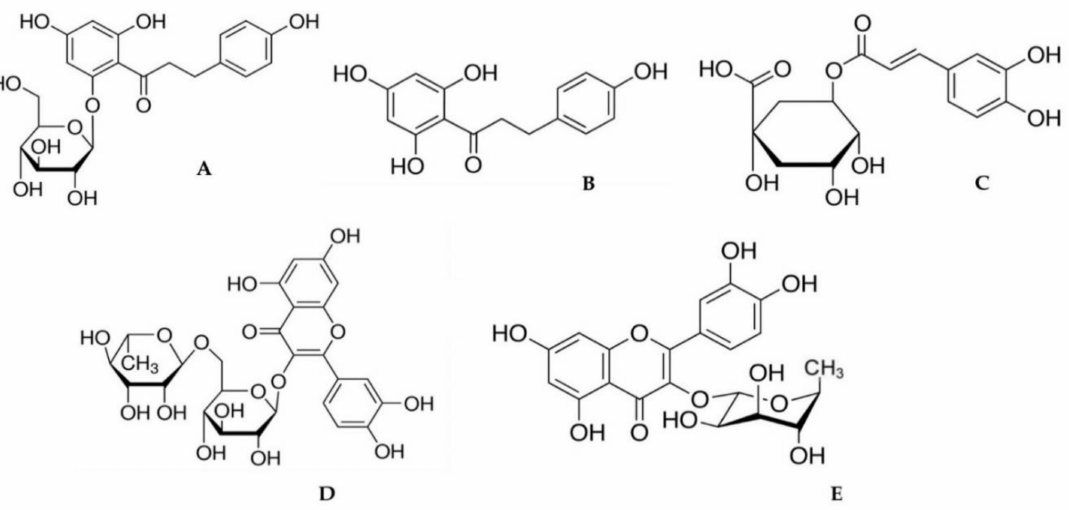
Figure 1. Chemical structure of ( A ) phloridzin, ( B ) phloretin, ( C ) chlorogenic acid, ( D ) rutin, and ( E )